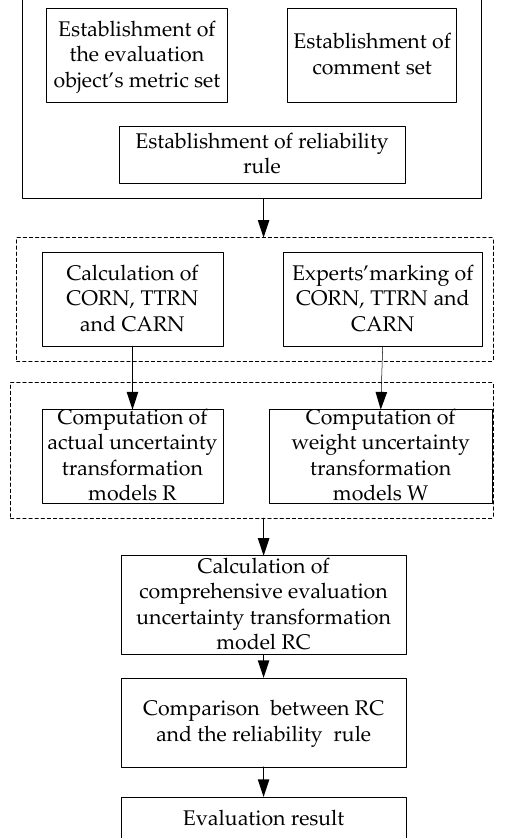
Figure 4. The architecture of reliability evaluation based on the uncertainty transformation model.